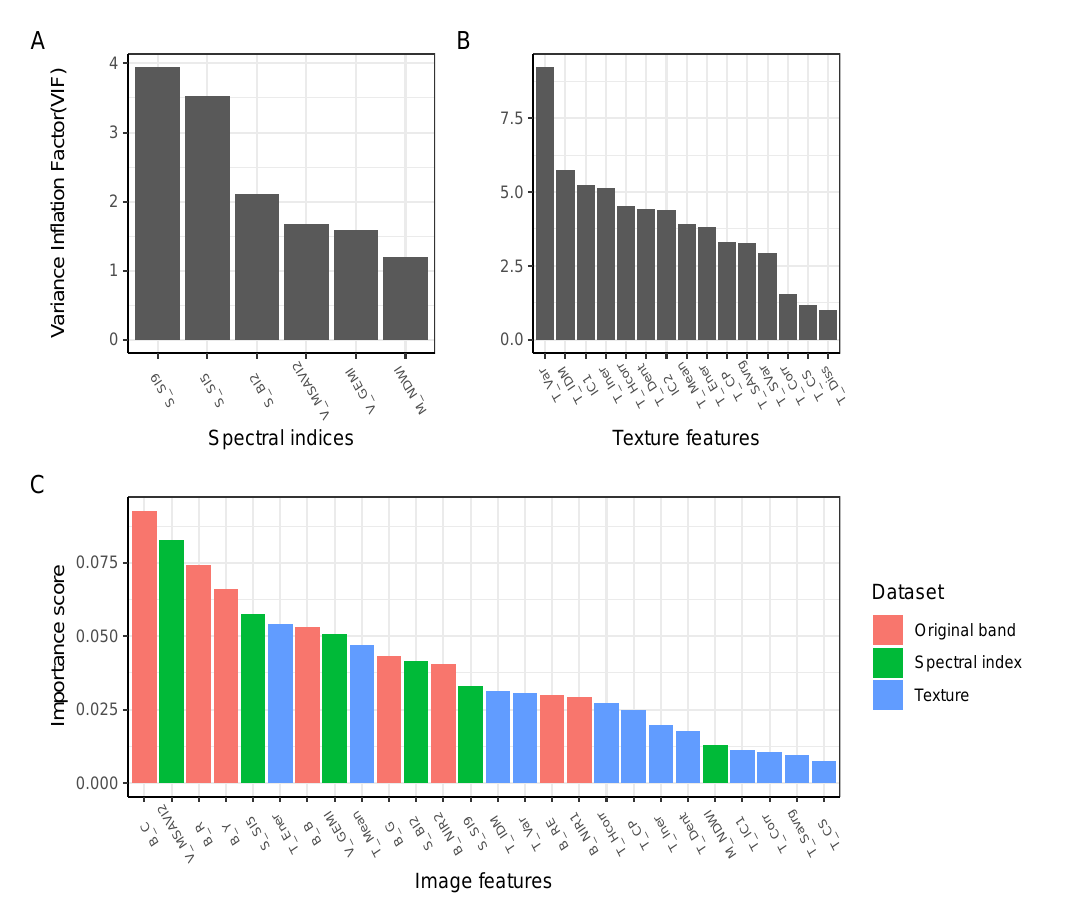
Figure A2. Feature selection results from VIF and RF-RFE analysis. ( A ) VIF of selected spectral indices. ( B ) VIF of selected texture features. ( C ) Importance scores of final selected image features following RF-RFE. Original bands and selected spectral indices and texture features from VIF served as input to RF-RFE. Final selection was based on number of features that retained optimal